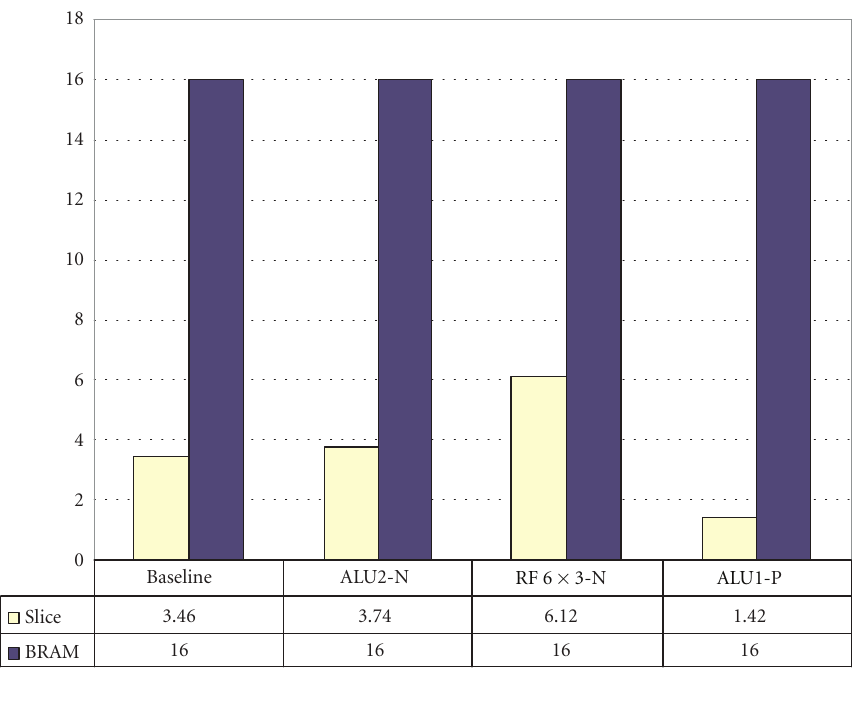
Figure 23: Area comparison for Mp3 relative to implementation on